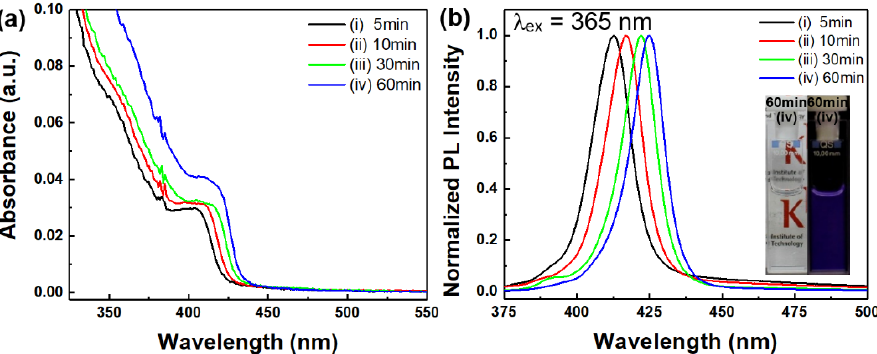
Figure 1. ( a ) Absorption and ( b ) PL spectra of the as-synthesized ZnSe C QDs as a function of reac- tion time ((i) 5 min, (ii) 10 min, (iii) 30 min, and (iv) 60 min)). The inset in ( b ) shows photographs of the ZnSe C QD solution (reaction time was 60 min) under indoor light (left) and UV light (right, λ = 365 nm).